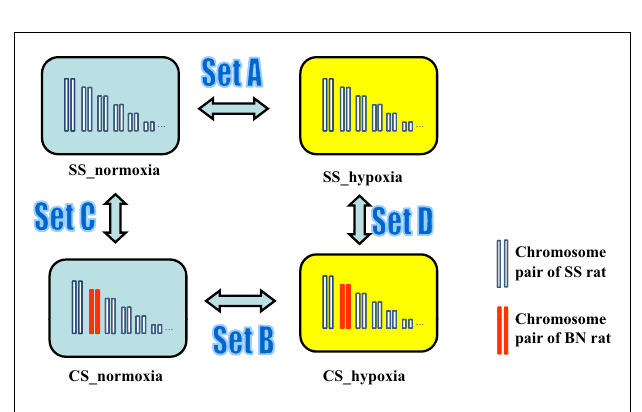
FIGURE 5 | Experimental design for the microarray study of the transcriptomic shift in consomic rat platform induced by (i) Hypoxia treatment (SetA gene expression alterations), (ii) BN consomic chromosome substitution (Set C gene expression alteration), (iii) synergistic effects of hypoxia and consomic (Set B), and CS-chromosome induced effect under hypoxia condition (Set D).